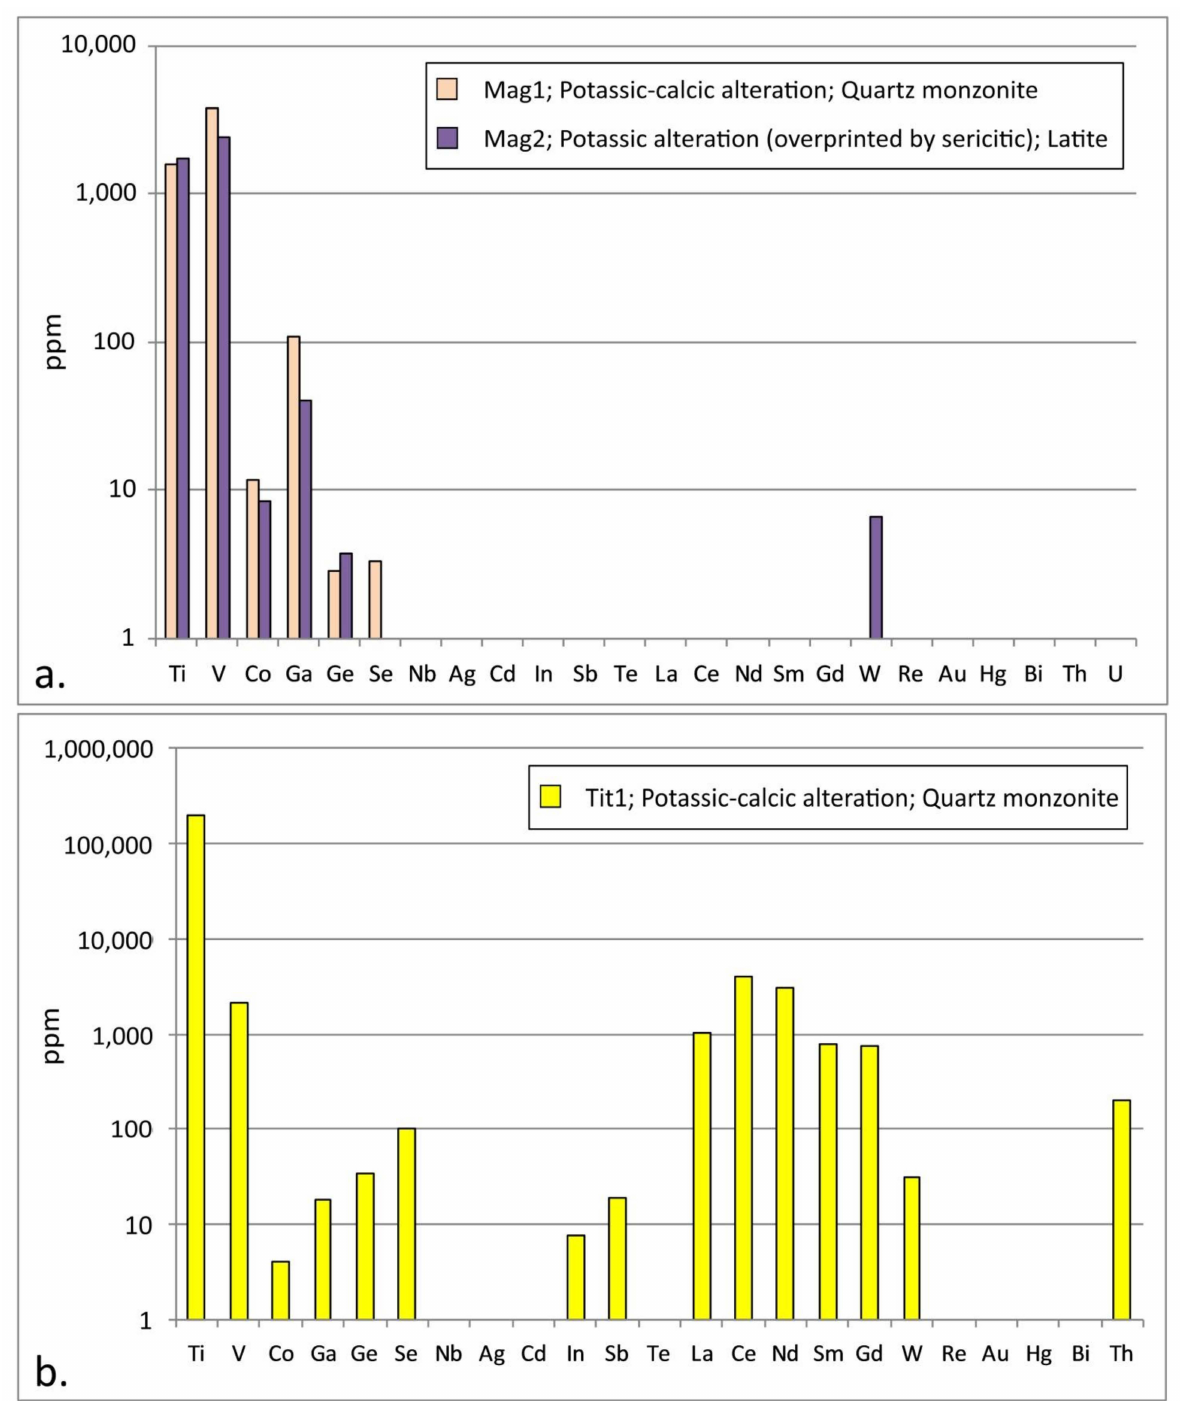
Figure 10. Average values of rare metal concentrations of ( a ) magnetite and of ( b ) titanite from various mineralization stages. Values are in ppm. Local enrichments related to nano-scale mineral inclusions are